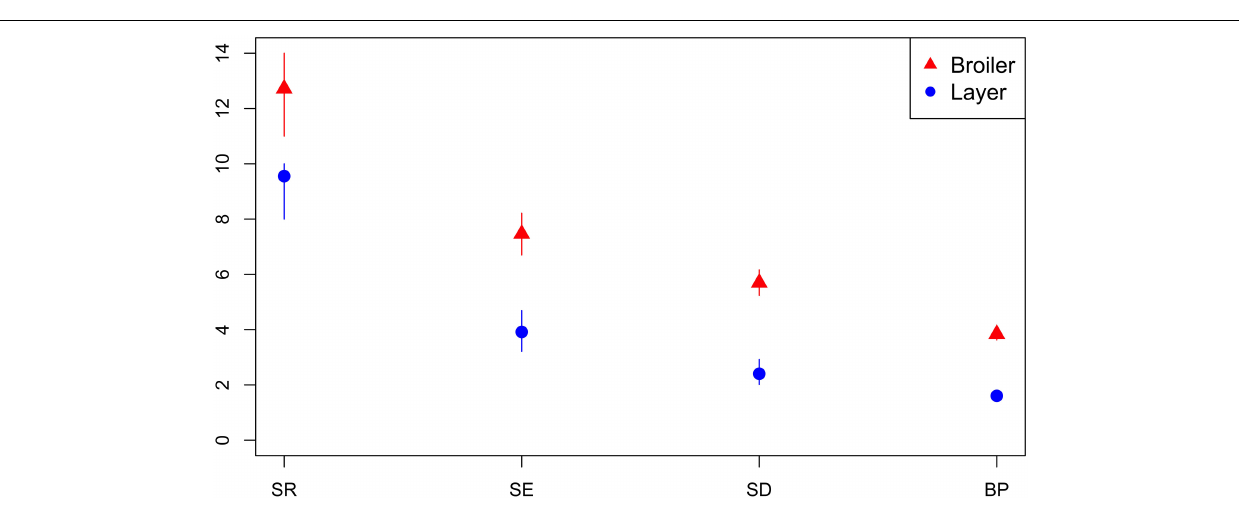
FIGURE 7 | Observed ecological diversities of phenotypic antimicrobial resistance profiles of S. Typhimurium isolates from broiler and layer